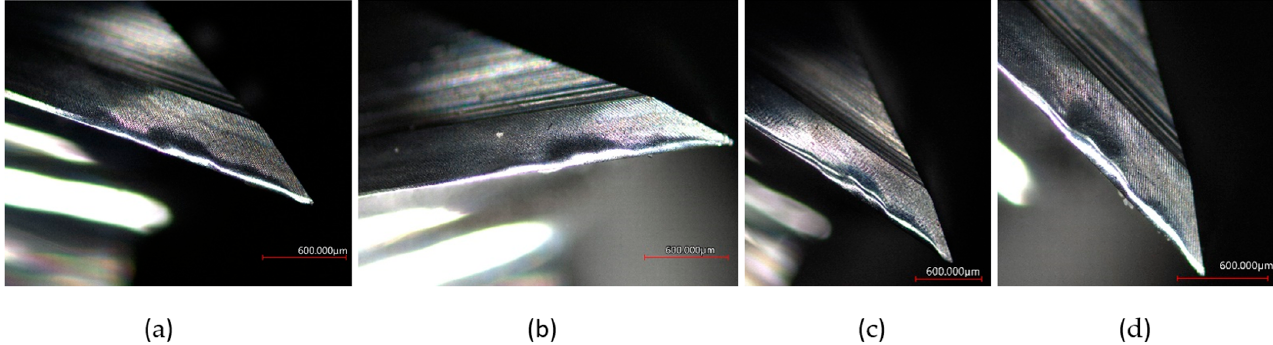
Figure 26. Tool wear of the ECSSF milling tool, laminate thickness 1 mm. ( a ) Tool tooth path 5 × 165 m; ( b ) tool tooth path 10 × 165 m; ( c ) tool tooth path 15 × 165 m; ( d) tool tooth path 20 × 165 m.